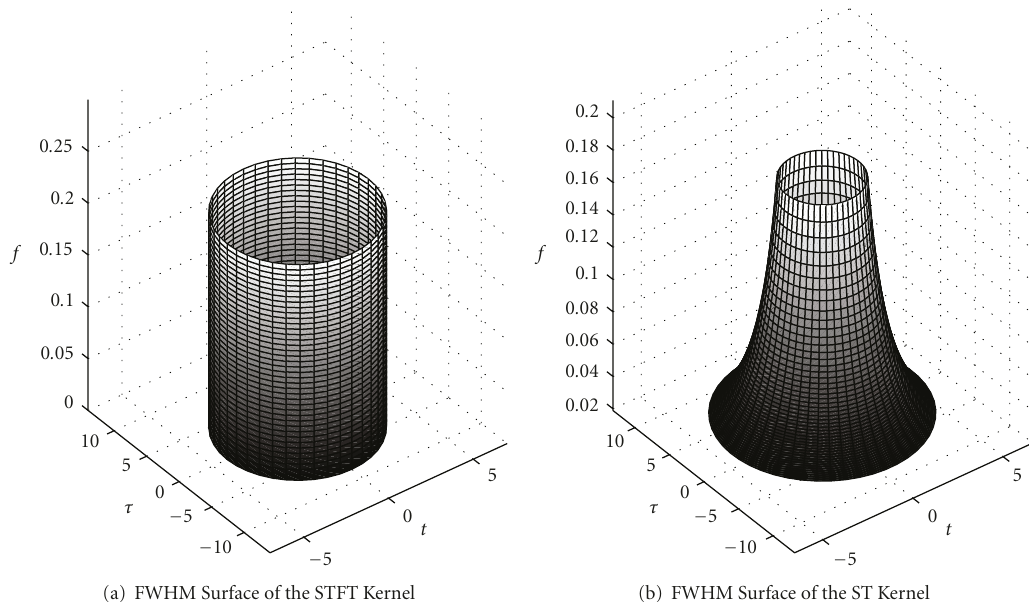
Figure 2: The surface of the time-lag kernel at the location of half maximum for (a) the GT- and (b) ST-spectrogram.